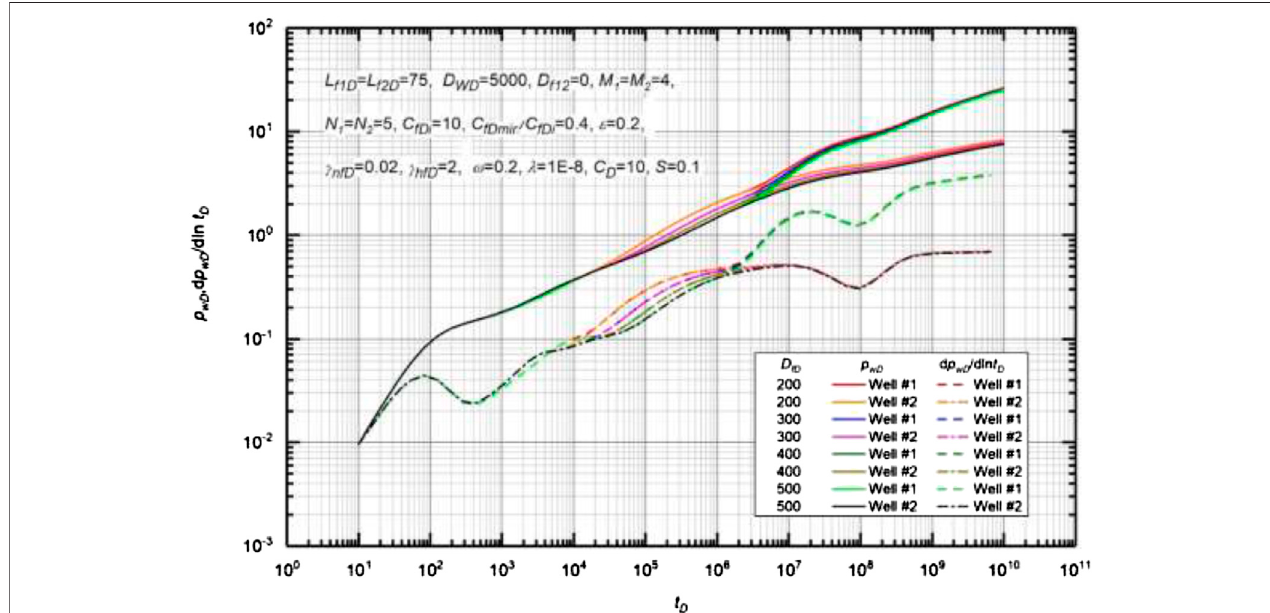
FIGURE 10 | Effect of HF spacing on the transient pressure for MWPMF.